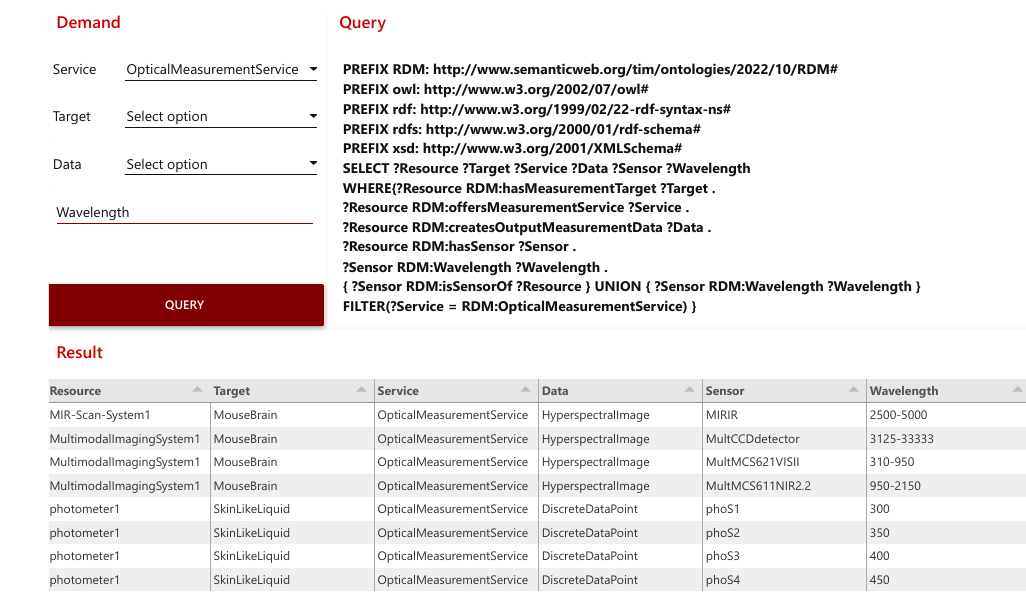
Figure 7. Node-RED Dashboard—Query Functionality for Specification-Driven Device Recommendation.